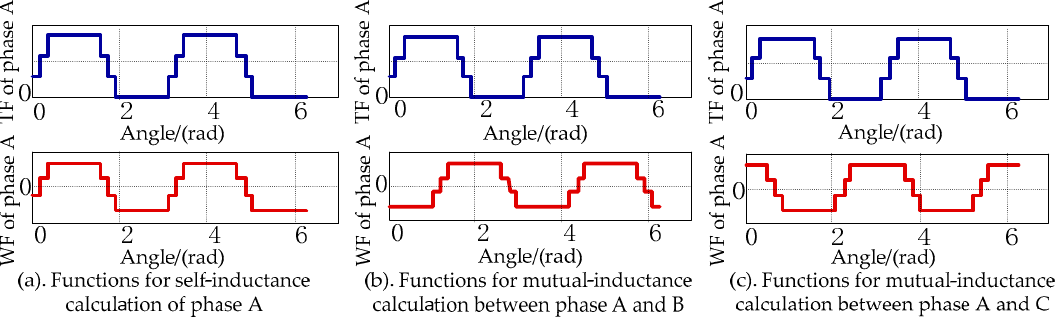
Figure 4. Turn functions (TFs) and winding functions (WFs) of stator phases.